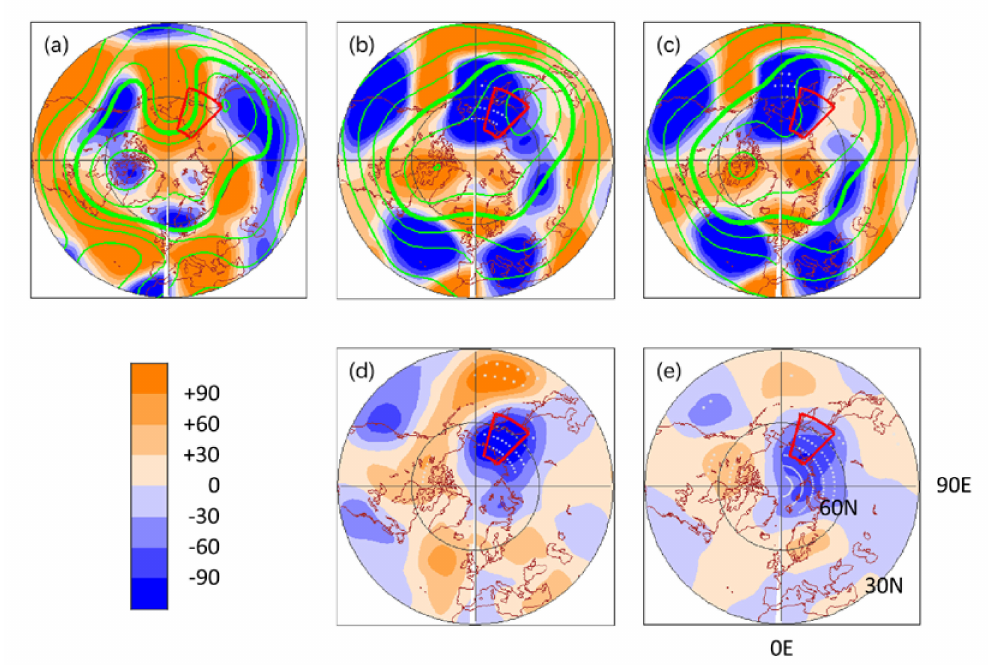
Figure 12. Same as Figure 6, but using the J11 initialization for the second cluster. Panel ( a ) plots the JRA-55 data, ( b ) MSSW member mean, and ( c ) non-MSSW member mean. Panel ( d ) plots the di ff erence of ( b ) from ( c ). Panel ( e ) plots the regression field onto the heat flux. The highlighted region in red is used for Figure